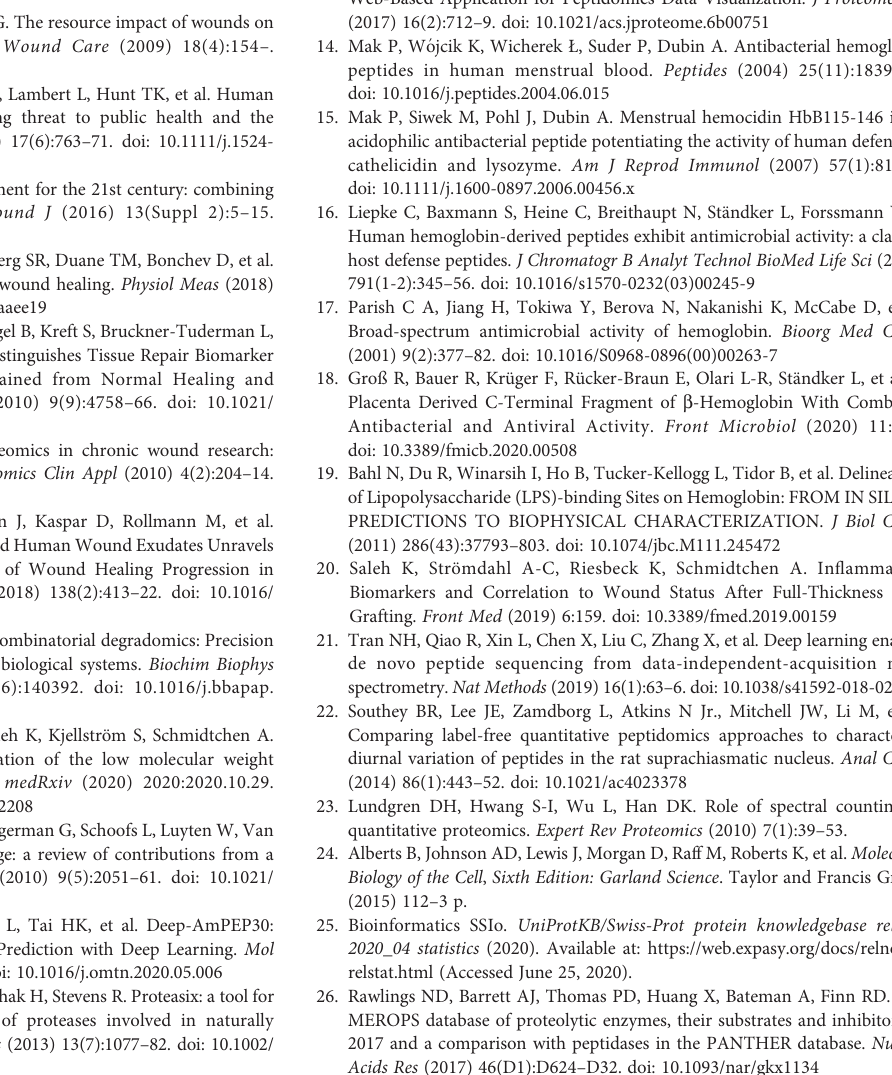
Supplementary Figure 3 | Protein pie charts without hemoglobin. The fi gure shows pie charts where hemoglobin derived peptides have been excluded from the dataset. The size of the pies are proportional to the total spectral count of peptide deriving from each protein. Supplementary Figure 4 | Amino acid distribution with aureolysin. The pie charts show the amino acid distribution ofcomplete sequences, P1and P1 ’ position ofthe peptides. The pie charts representing aureolysin degradation were made in the same way but using the dataset from the degradation of thrombin by aureolysin (32). Supplementary Figure 5 | Identi fi cation of the most abundant characteristics behind the N- and C-terminals. (A) Scatter plots visualizing the distribution of the characteristics of N-terminals (the fi rst 4 amino acids) and C-terminals (the 4 last amino acids) by plotting the aggregated spectral count after grouping amino acids by side chain properties (22). A difference in curvature in the different groups can be seen. (B) Table showing the sequence and average spectral count of the most abundant terminals, which are highlighted in the scatter